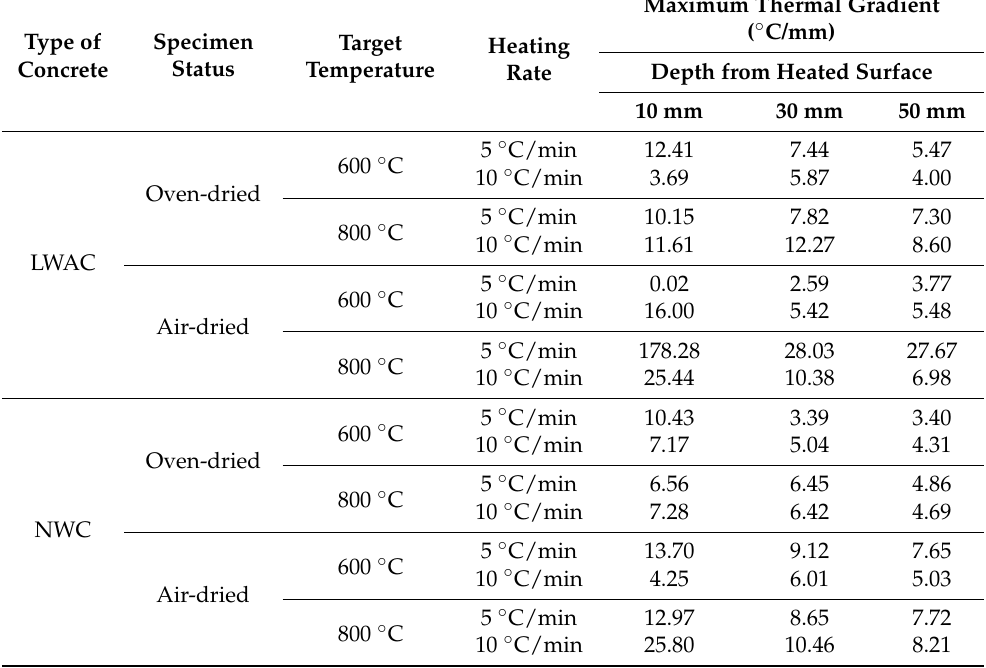
Table 7. Maximum thermal